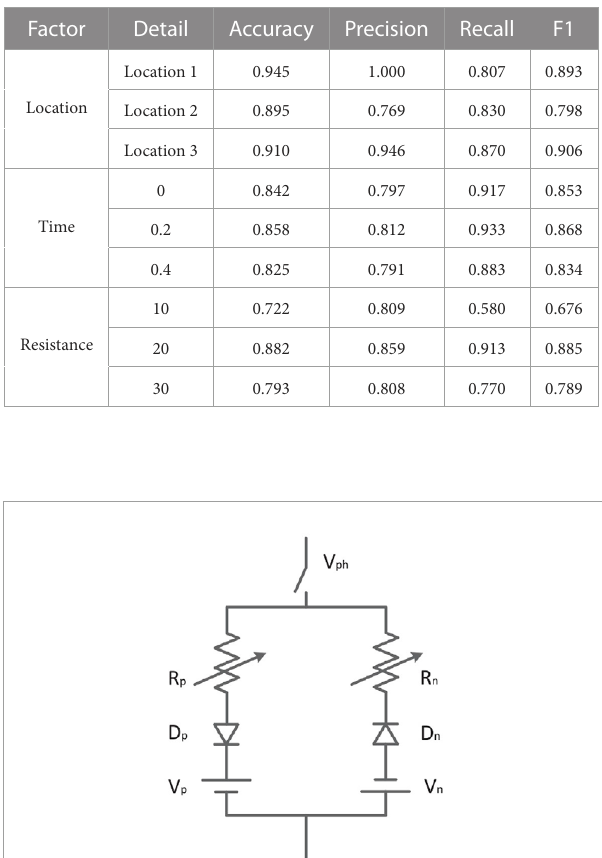
TABLE4 SystemconfigurationunderdifferentDERtechnologies. TABLE5 Simulationresultsofcableincipientfaultsidentification.